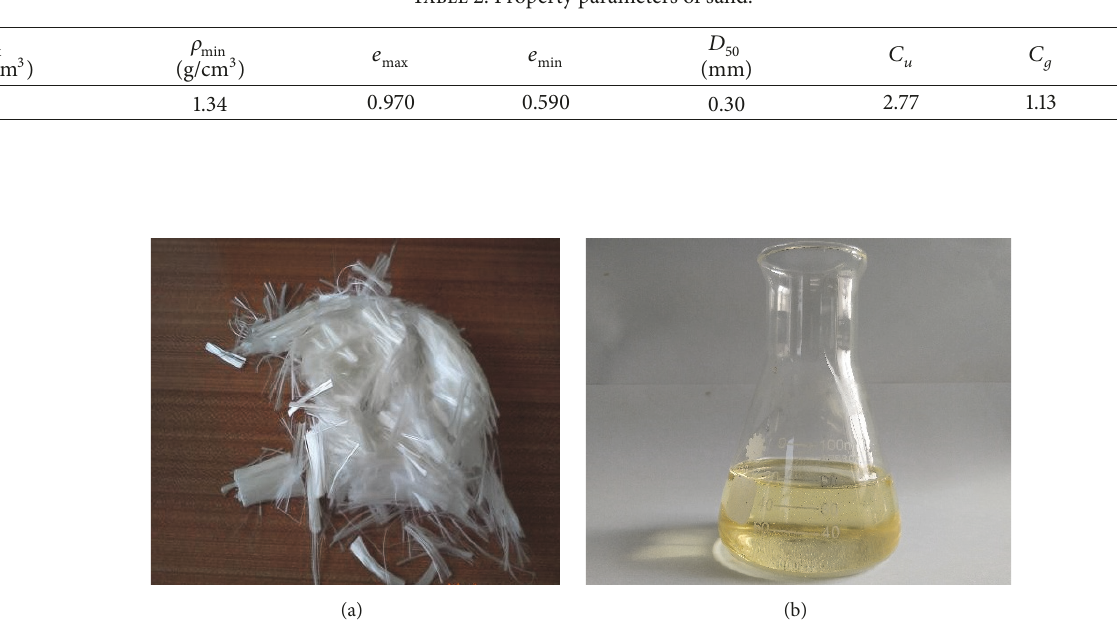
Figure 1: The polymer-fiber material: (a) polypropylene fiber; (b) polyurethane organic polymer.